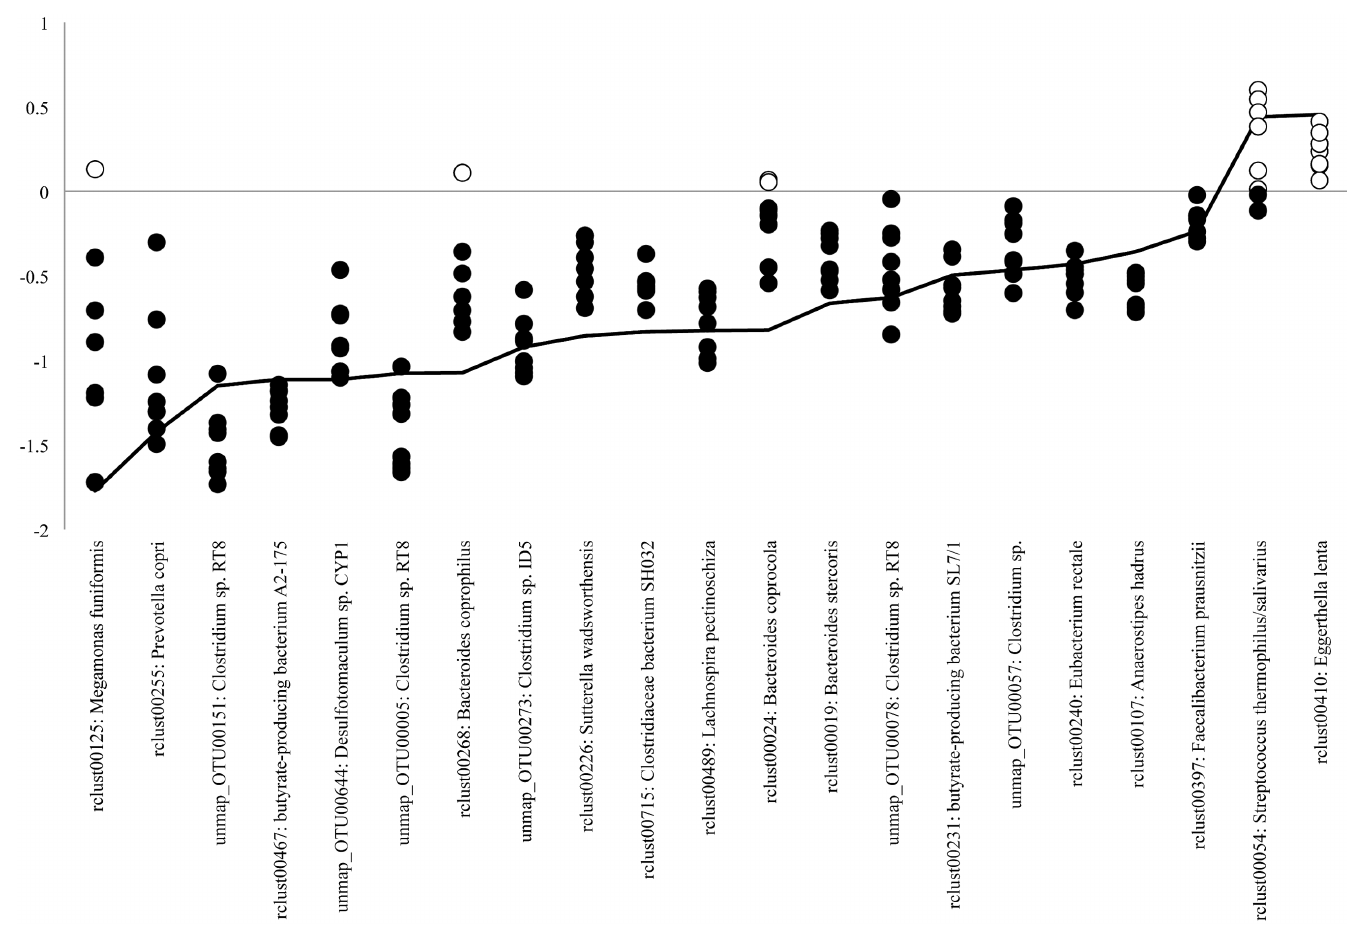
Fig 6. Fold-change in the abundance of 21 species using longitudinal HC18 samples. The vertical axis indicates the log value of fold-change in the abundance of 22 species for the comparison between MS20 and HC18 (nine longitudinal samples per individual) samples. Open and closed circles indicate log values of fold-change > 0 (increased in MS) and < 0 (decreased in MS), respectively. The average fold-change in the abundance of each species for the comparison between MS20 and HC40 samples was connected by a